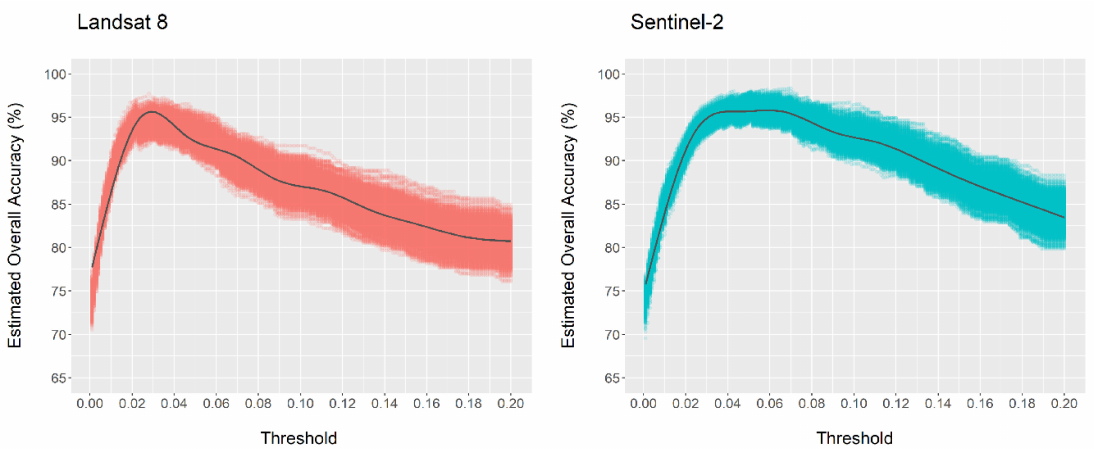
Figure 4. Estimated overall accuracies [62] of disturbance maps derived from 200 ∆ rNBR thresholds, based on the bootstrapping approach applied for Landsat 8 and Sentinel-2 data (bootstrap average appears as a smooth